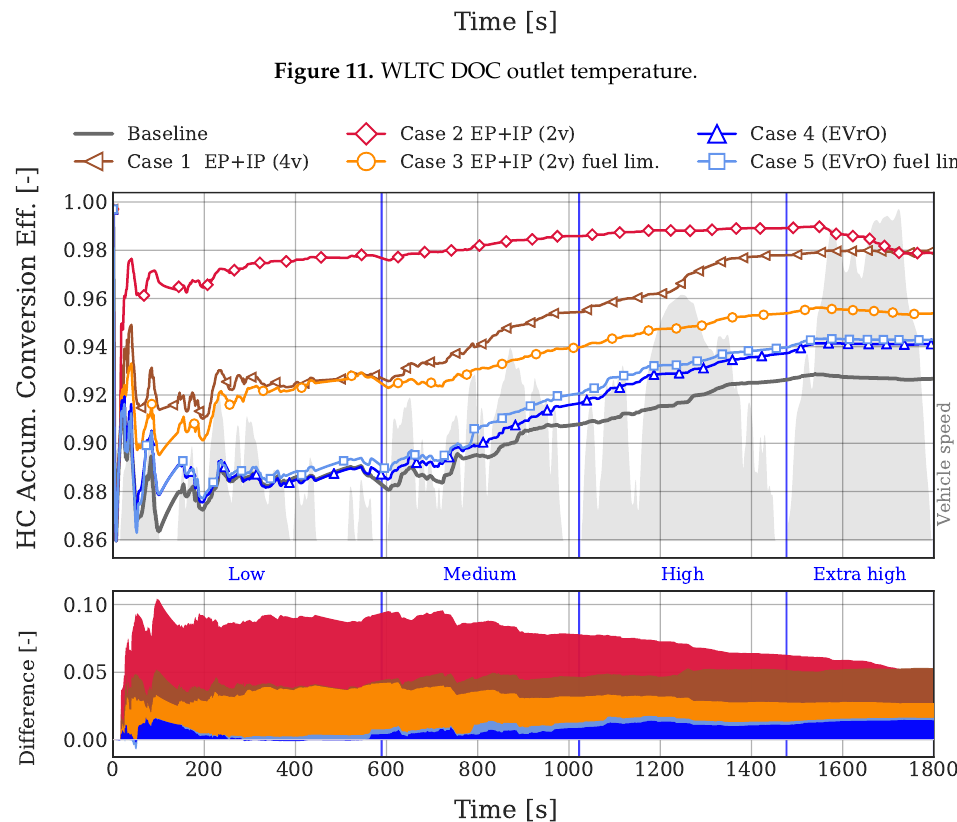
Figure 12. WLTC HC accumulated conversion